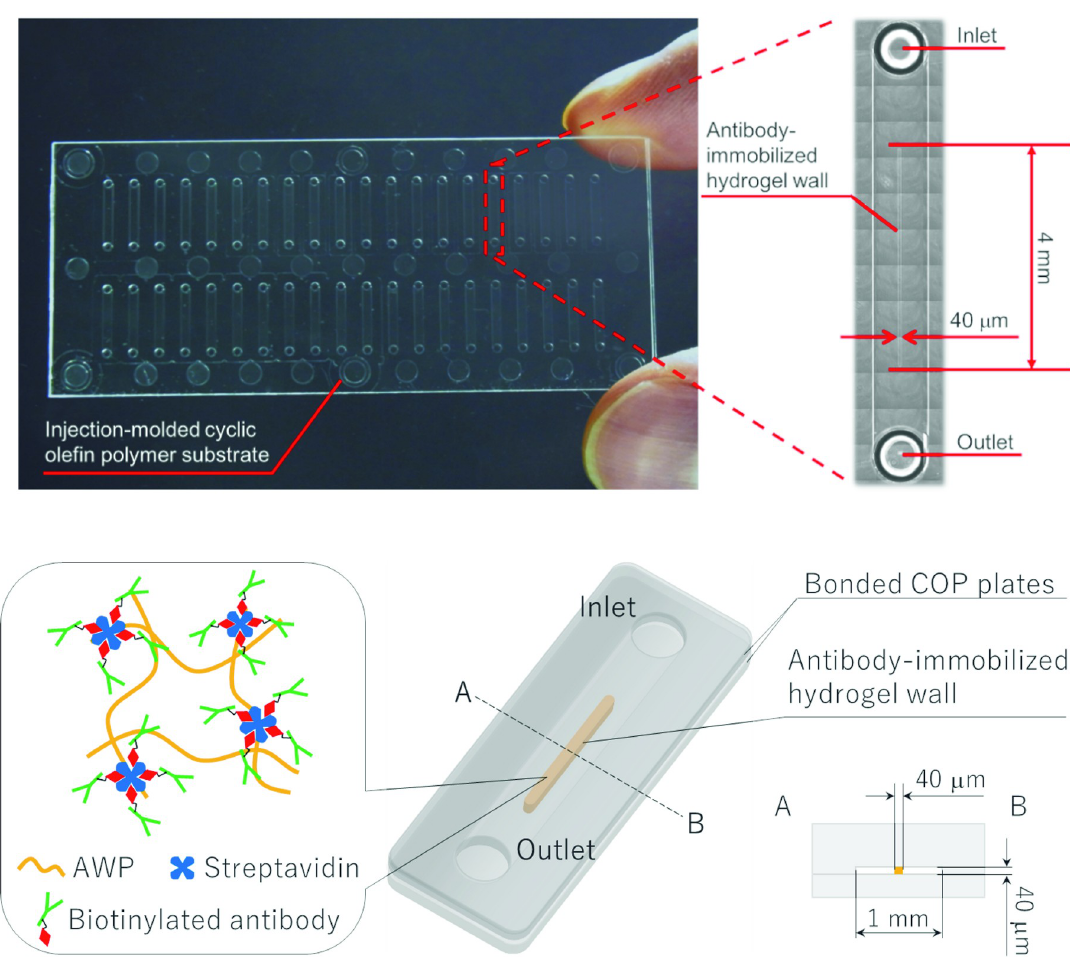
Fig 1. Picture and schematic of the immuno-wall